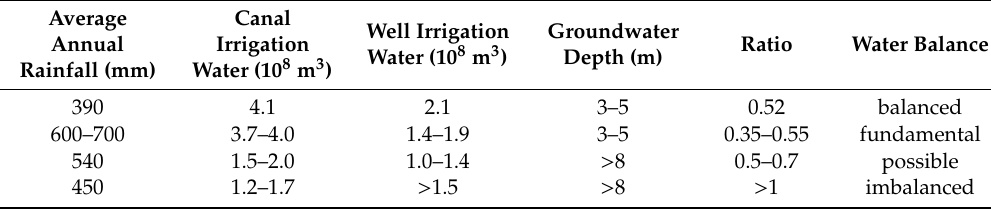
Table 1. Summary of groundwater recharge and discharge balance.